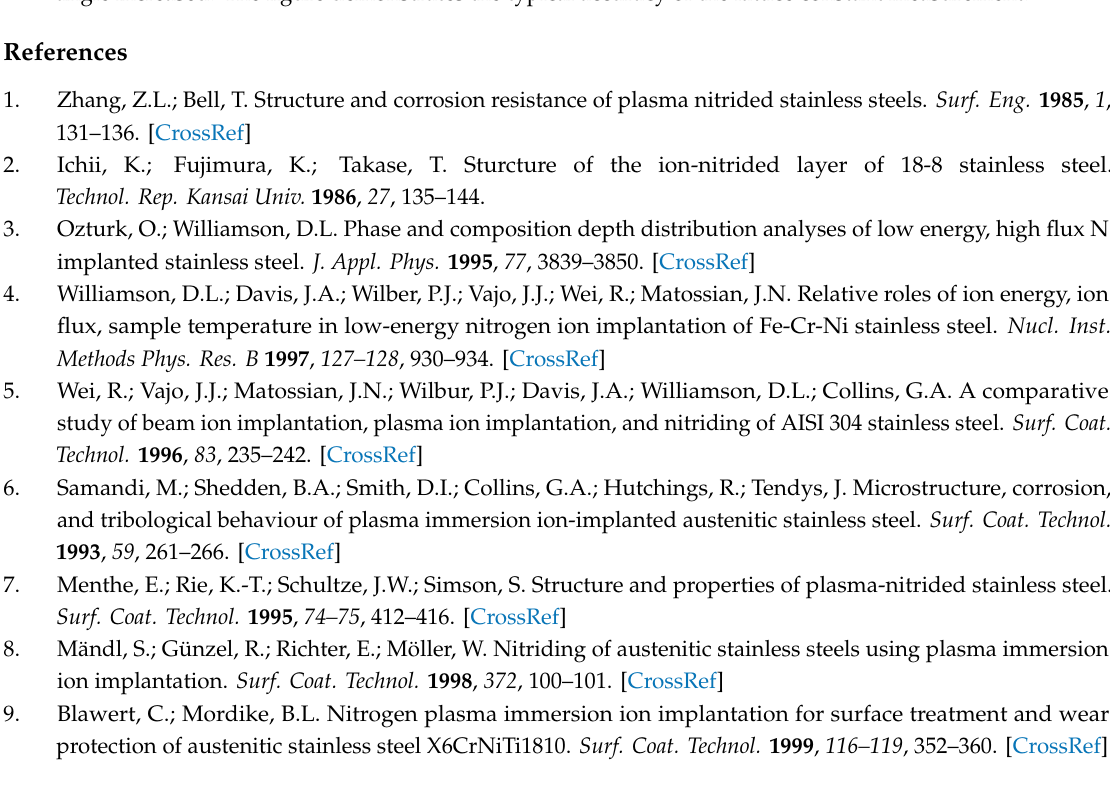
Figure A1. Measured lattice constants for a Cu powder based on the (111) and (200) reflections vs. ϕ , angle increased. The figure demonstrates the typical accuracy of the lattice constant